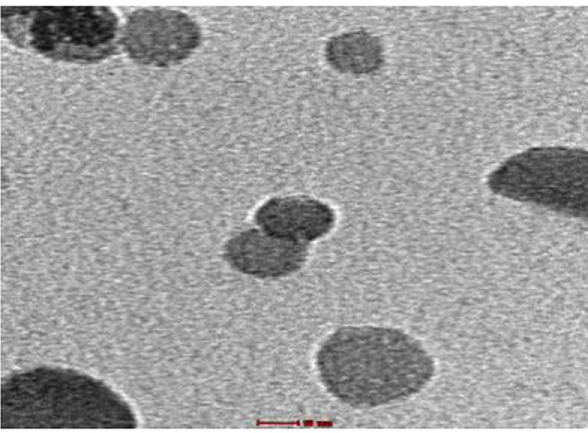
Fig 18. TEM result for HAp powder at optimal conditions (time = 10 h, pH = 10, temperature = 130˚C).